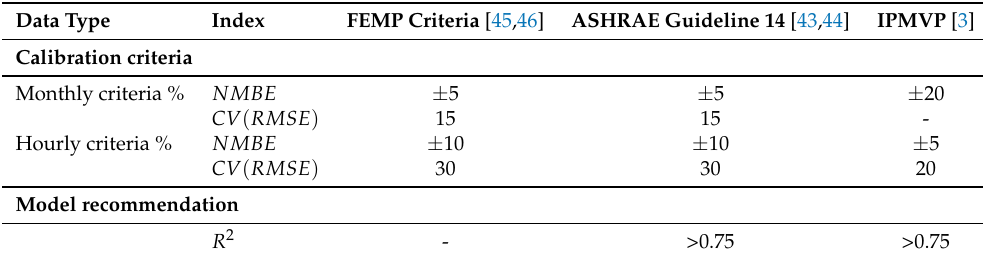
Table 2. Calibration criteria of the Federal Energy Management Program (FEMP), ASHRAE Guideline 14 and IPMVP. CV ( RMSE ) : coefficient of variation of the root mean square error; IPMVP: International Performance Measurements and Verification Protocol; NMBE : normalized mean bias